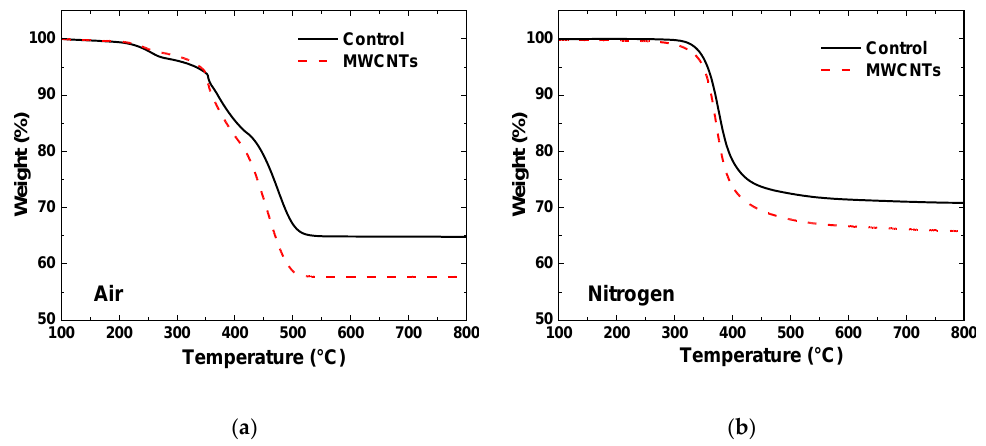
Figure 4. TGA thermographs for the control and MWCNT specimens tested in an ( a ) air and ( b ) nitrogen environments.